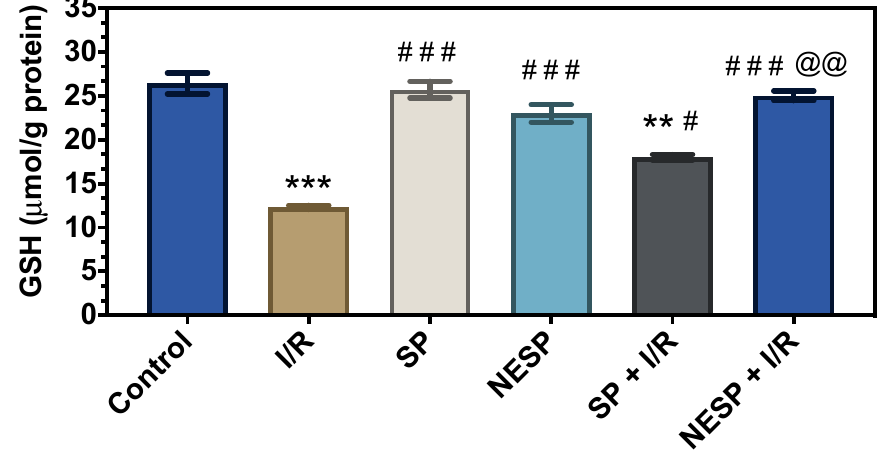
Figure 3. Renal glutathione (GSH) levels in different animal groups ( n = 8) at the end of interventions: Control, ischemic/reperfusion (I/R), spironolactone (SP), nano-encapsulated spironolactone (NESP), spironolactone-treated I/R (SP + I/R) and NESP-treated I/R (NESP + I/R) groups. ** p < 0.01 and *** p < 0.001 (compared to control group). # p < 0.05 and ### p < 0.001 (compared to I/R group). @@ p < 0.01 (difference between SP-treated I/R group and NESP-treated I/R